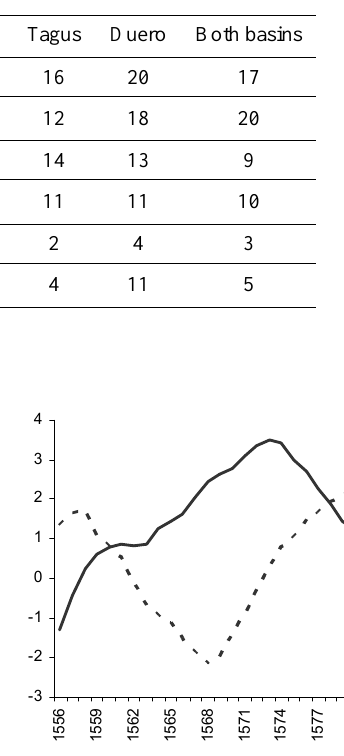
Figure 4. Standard five-year moving average curves of floods (solid line) and Fig. 4. Standard five-year moving average curves of floods precipitation (broken line). For both basins, Y-axis = deviation from normal values; X- (solid line) and precipitation (broken line). For both basins, axis = years. Y-axis=deviation from normal values; X-axis=yr.